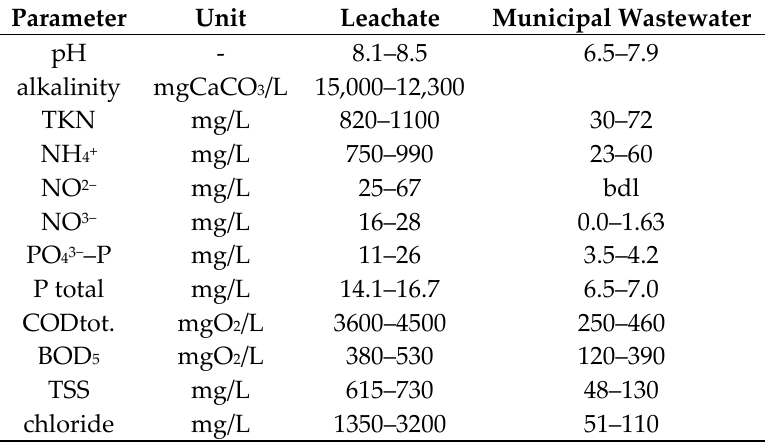
Table A1. Characteristic of wastewater used in this study.